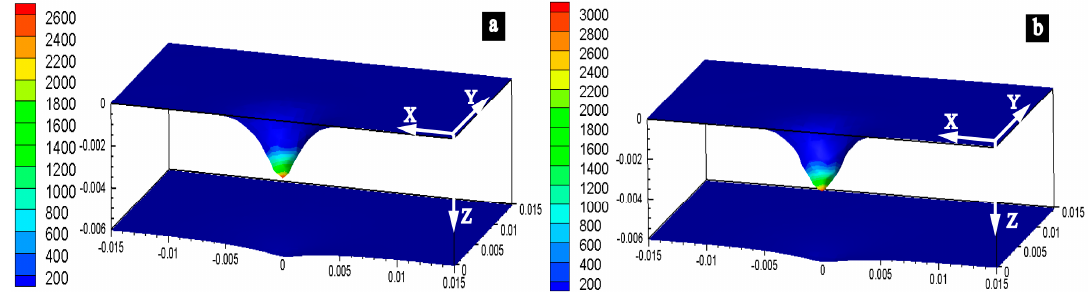
Figure 9. The arc pressure value in ( a ) direct current electrode negative (DCEN) phase and ( b )direct current electrode positive (DCEP) phase obtained by simulation.